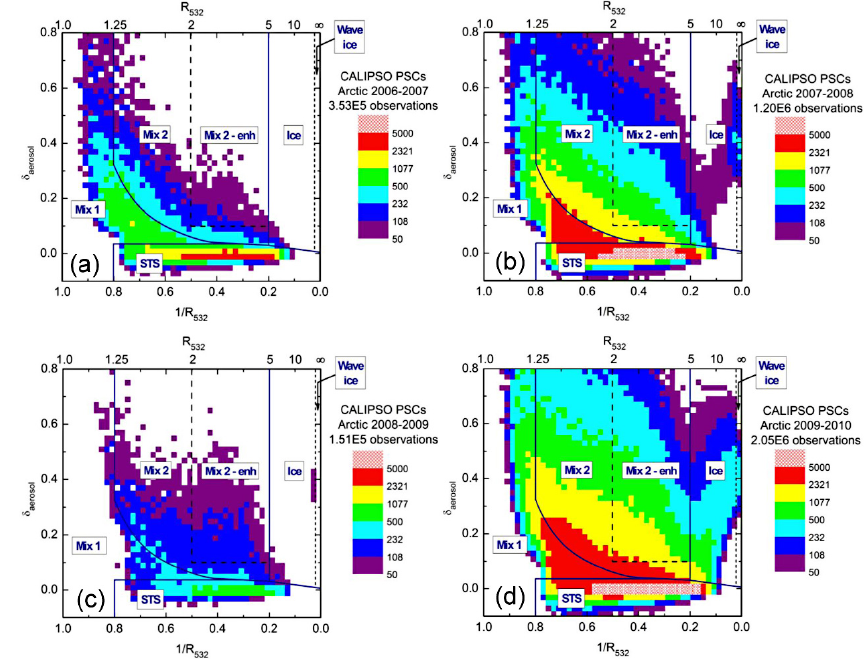
Fig. 10. Composite 2-D histograms of CALIPSO PSC observations from each of the last four Arctic seasons in the δ aerosol vs. 1/ R 532 coordinate system, with the domains of the CALIPSO PSC composition classes overlaid.